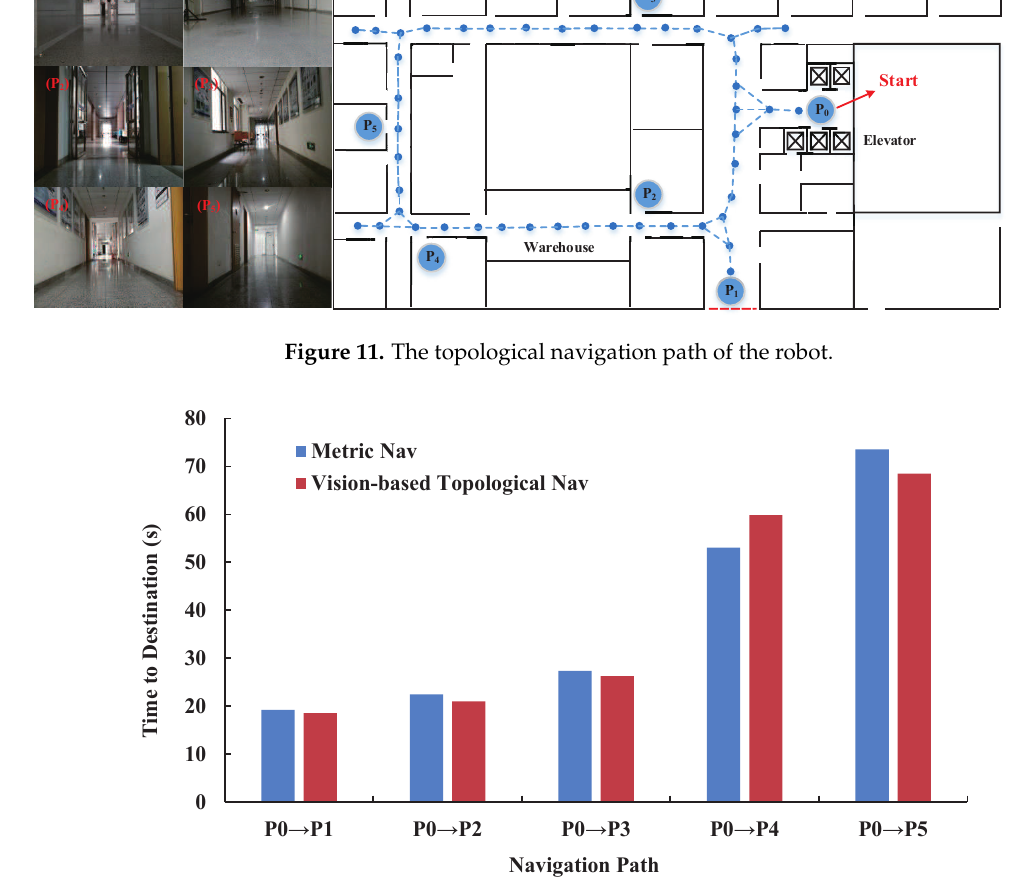
Figure 12. Time cost of each navigation method. Each trial was performed 5